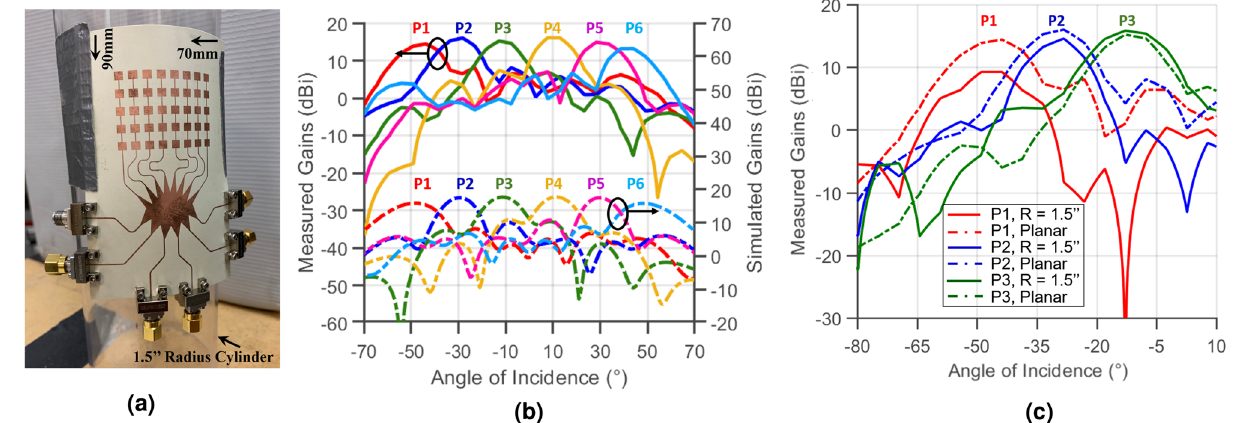
Figure 3. ( a ) Picture of the flexible Rotman-lens-based antenna array, ( b ) measured (solid lines) and simulated (dashed lines) gains of the antenna array held in a planar position and ( c ) measured gains of the antenna